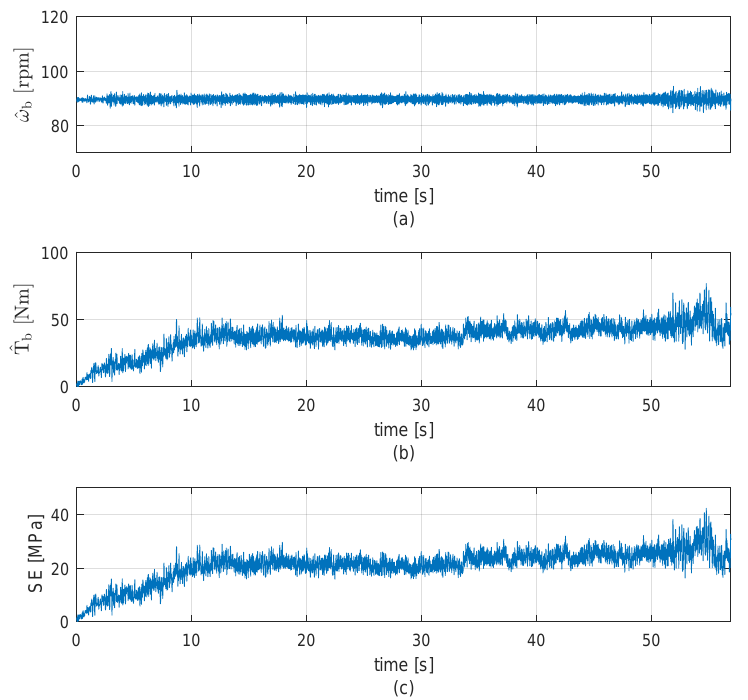
Figure 11. Evaluation of observer-based MWD system during drilling condition of QR-R4, estimated variables: ( a ) ˆ ω b ; ( b ) ˆ T b ; ( c ) SE